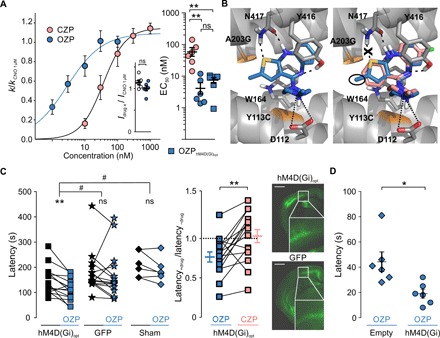
OZP is a potent agonist at hM4D(Gi).(A) Left: Dose-response curves for CZP and OZP at hM4D(Gi). The inset shows the efficacy of OZP (100 nM) and CZP (1 μM), normalized to 1 μM CNO as a positive control (CZP/CNO = 1.14 ± 0.06; n = 6; OZP/CNO = 1.01 ± 0.06; n = 6; P = 0.12, Student’s t test). Right: EC50 for CZP at hM4D(Gi), and OZP at hM4D(Gi) and at the codon-optimized hM4D(Gi)opt [CZP: hM4D(Gi) EC50 = 61 ± 19 nM, n = 6; OZP: hM4D(Gi) EC50 = 5 ± 2 nM, n = 6, P < 0.01 in comparison to CZP hM4D(Gi); OZP: hM4D(Gi)opt EC50 = 7 ± 2 nM, n = 6, P < 0.01 in comparison to CZP hM4D(Gi); one-way ANOVA with Bonferroni post hoc test]. ns, not significant. (B) Docking poses of OZP (left, blue sticks) in comparison to CZP (right, rose sticks) in the homology model of active hM4D(Gi) (gray cartoon and sticks). Ionic interactions with D112 and hydrogen bonds are highlighted by dotted and dashed lines, respectively. The methyl group of OZP is highlighted in the right panel. The Y113C and A203G mutations are highlighted in orange, and residues 434 to 443 are not depicted for clarity. (C) Left: Latency to fall of animals injected with AAV2/8-hCamKII-hM4D(Gi)opt [before OZP: 149 ± 14 s; after OZP (0.1 mg/kg, i.p.): 111 ± 11 s; n = 15; **P = 0.002, paired Student’s t test], those injected with AAV2/8-hCamKII-GFP (before OZP: 180 ± 21 s; after OZP: 169 ± 25 s; n = 15), and sham-injected animals (before OZP: 212 ± 21 s; after OZP: 189 ± 20s; n = 6; **P < 0.01, Student’s paired t test; #P < 0.05, repeated-measures ANOVA with LSD post hoc test). Middle: Normalized latency to fall of AAV2/8-hCamKII-hM4D(Gi)opt–injected animals treated with either OZP (0.1 mg/kg) (0.76 ± 0.06; n = 15) or CZP (0.1 mg/kg) (1.03 ± 0.08; n = 15; **P = 0.033, Student’s paired t test). Right: Representative confocal fluorescence images of mouse brains injected with either AAV2/8-hCamKII-hM4D(Gi)opt (DREADD, −1.3 mm from bregma) or AAV2/8-hCamKII-GFP (GFP, −1.2 mm from bregma) (scale bars, 1 mm). (D) Latency to fall after OZP (0.1 mg/kg, i.p.) in animals injected with either AAV2/5-hCamKII-hM4D(Gi) or AAV2/5-hCamKII-empty bilaterally into striatum [AAV2/5-hCamKII-hM4D(Gi), 19 ± 4 s; n = 6; AAV2/5-hCamKII-empty, 44 ± 8 s; n = 6; P = 0.014, Student’s unpaired t test].